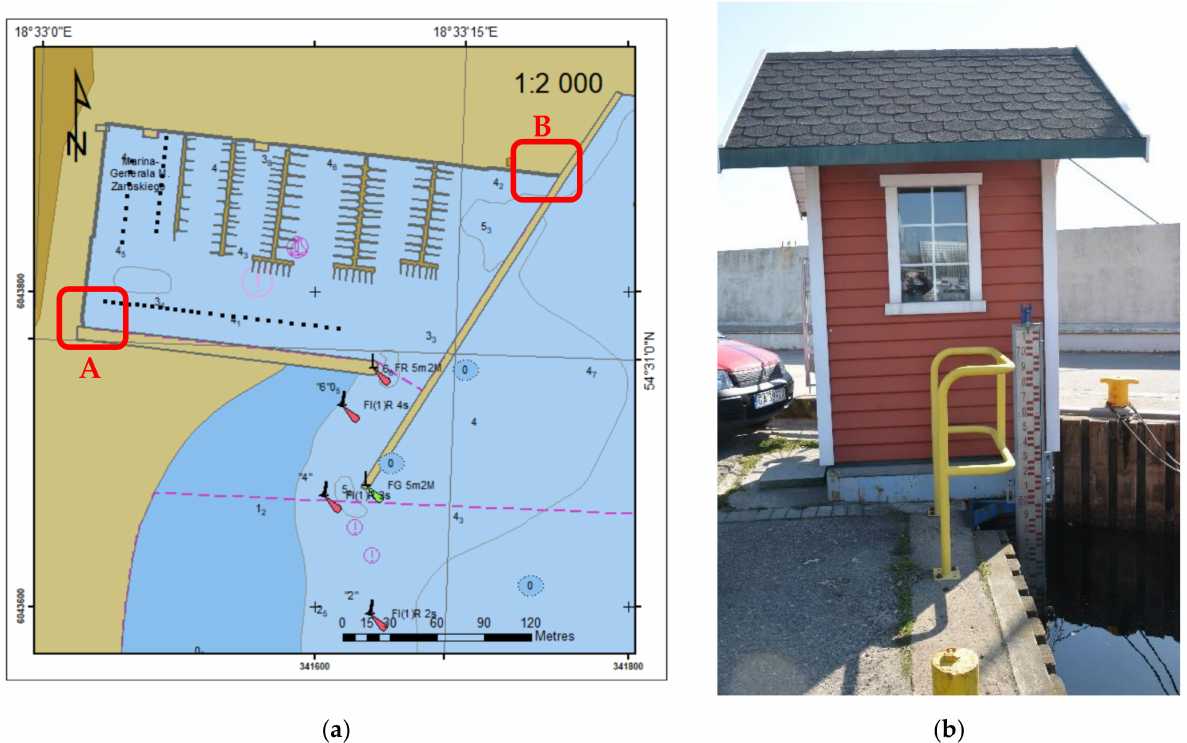
Figure 9. Location of measurements of the sound speed in water in Gdynia ( a ), A and water station ( b ), B. Measurements of vertical distribution of the sound speed in water were executed in that place and the bathymetric measurements at the area of the public beach. Similar to the marina, where the measurement of the sound velocity in water were executed, the depth reaches a value of 5 m in that place. marina and the public beach are shown in Figure 10.